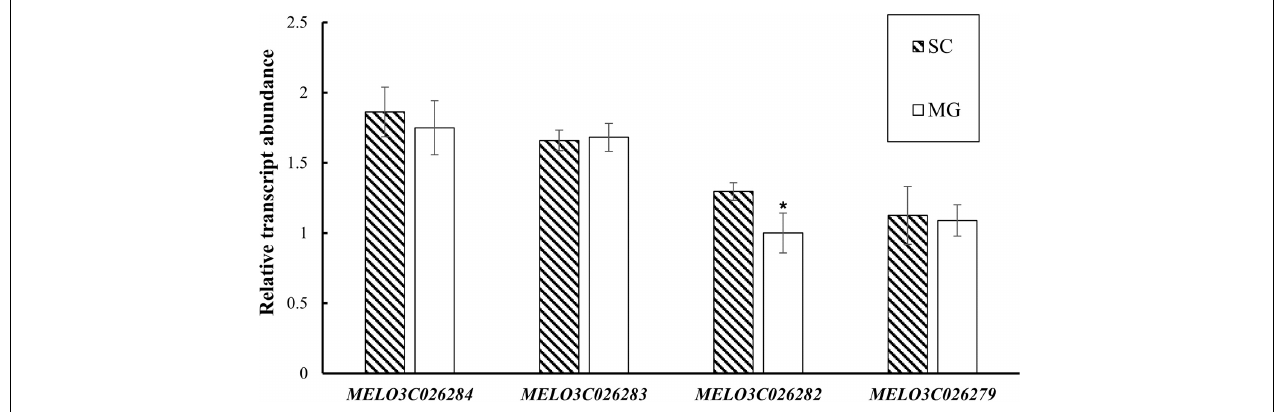
FIGURE 6 | Expression evaluation of MELO3C026284 , MELO3C026283 , MELO3C026282 , and MELO3C026279 by qRT-PCR. The values are shown as mean ± SD of three biological and three technical replicates. *Significant differences ( t -test, p <